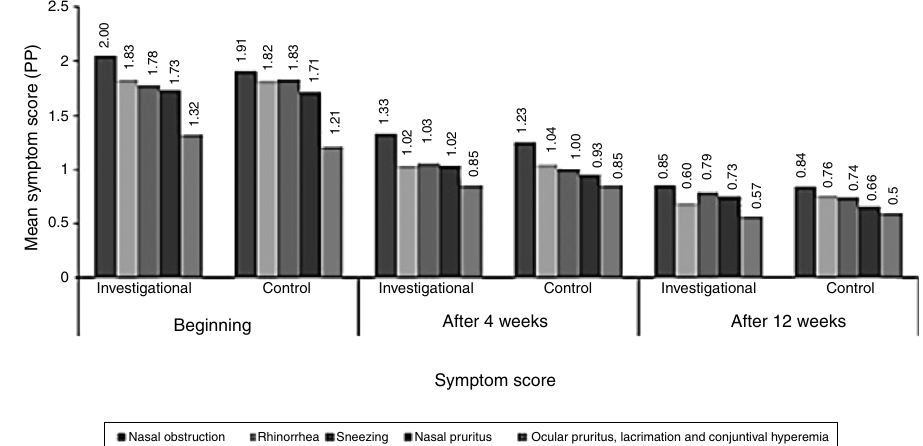
Ocular pruritus, lacrimation and conjuntival hyperemia Figure 2 Symptom score.